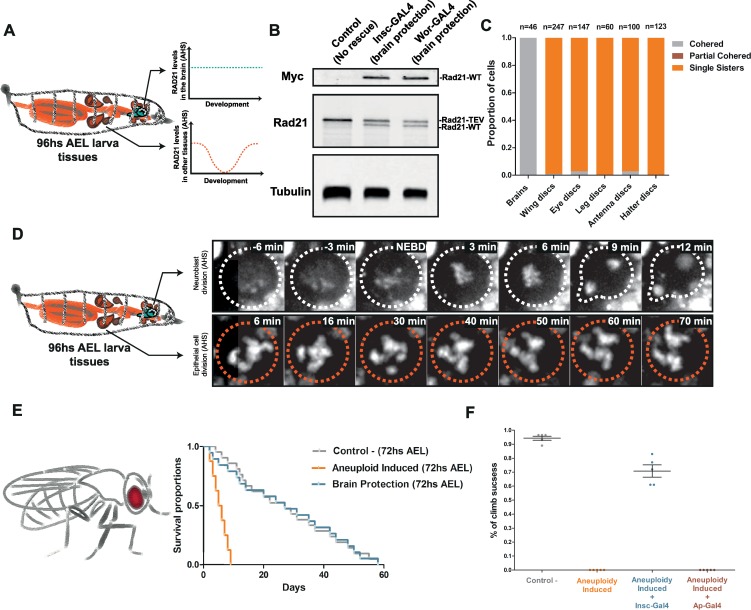
Protecting only the developing brain from induced aneuploidy rescues the adult life span.(A) Graphic scheme depicting how the developing brain is protected from the loss of cohesin and induction of aneuploidy upon the constitutive expression of the RAD21-WT driven by Nb-specific Gal4 (Insc-Gal4 or Wor-Gal4). In contrast, the rest of the dividing tissues from the larva experience the acute inactivation of cohesin complex (by TEV cleavage of RAD21-TEV) AHS. (B) Western blots showing the production of both cleavable RAD21-TEV and RAD21-WT, which is resistant to TEV cleavage, in third-instar brains. Insc-Gal4 and Wor-Gal4 drivers result in expression of RAD21-WT in the third-instar brain before the heat shock. (C) Quantification of cohesive states of third-instar larvae Nbs and epithelial cells from different imaginal discs following heat shock. Insc-Gal4 protects the brain from cohesin loss but has no effect in the imaginal discs. (D) Live-imaging cohesin profiles of Nbs and epithelial cells during mitotic divisions after the heat-shock. Insc-Gal4 prevents mitotic delay caused by cohesin loss in the Nbs. (E–F) (E) Kaplan–Meier survival curves showing fractional survival as a function of time. Protection of the brain tissue from the induced aneuploidy rescues the adult life span of the ecloded flies with 72 hours AEL heat shock. (F) Climbing assay of adult flies. Percentage of climb success was plotted over the halfway point (10 cm). Protection of the brain tissue from induced aneuploidy by using Insc-GAL4 rescues motor defects of the ecloded flies with the 72 hours AEL heat shock. Contrastingly, protection of the wing and haltere disc epithelial tissues by using apterous-GAL4 does not rescue the motor defects. Individual numerical values for the presented graphs can be found in S1 Data. AEL, after egg laying; AHS, after heat-shock induction; GAL4, yeast transcription activator protein Gal4; insc, inscutable; myc, protein tag derived from the c-myc gene product; Nb, Neuroblast; NEBD, Nuclear Envelope Breakdown; RAD21, Double-strand-break repair protein rad21 homolog; TEV, Tobacco Etch Virus; wor, worniu; WT, wild type.